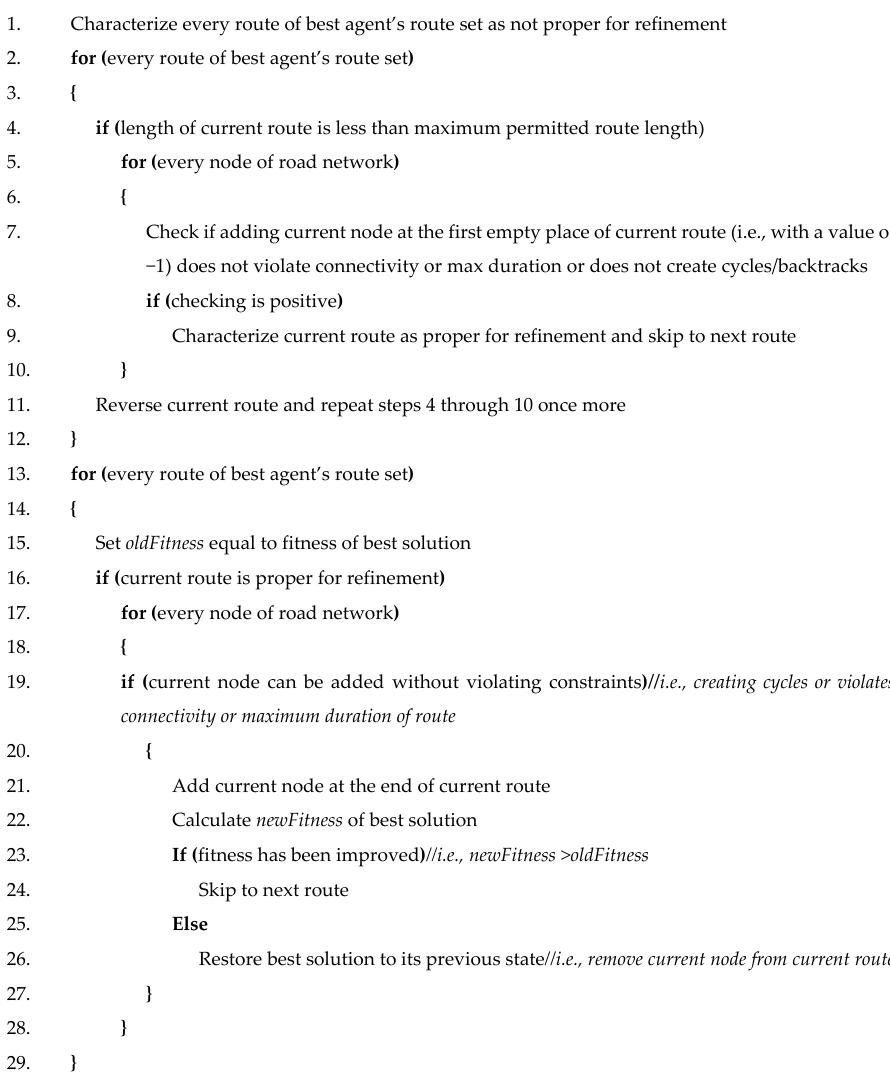
Figure 7. The pseudocode of the refinement procedure.